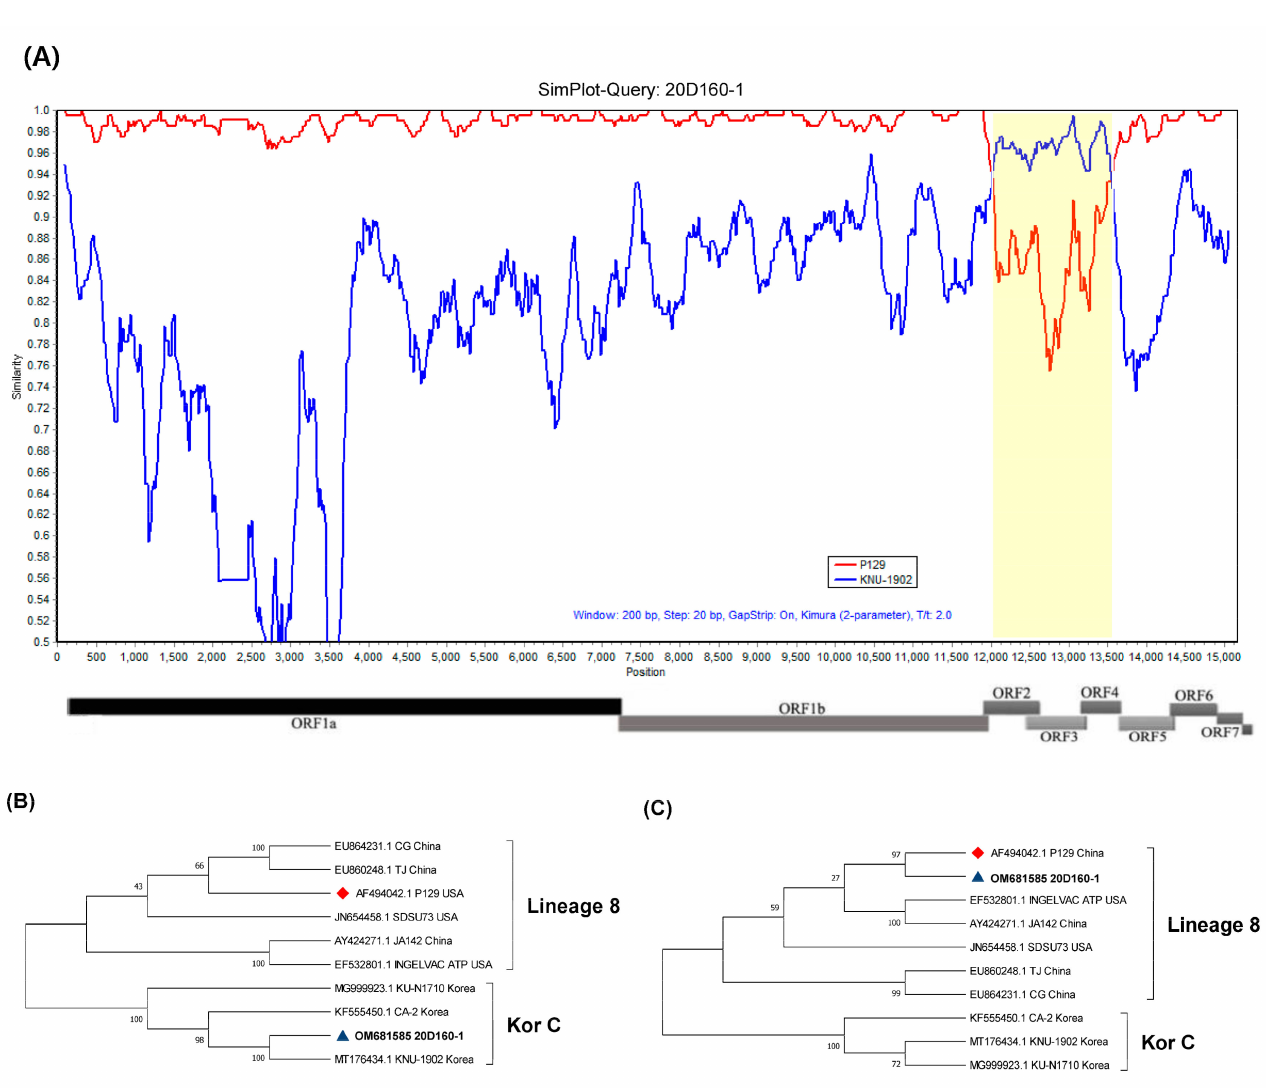
Figure 2. Recombination analyses of 20D160-1 and representative PRRSV lineages. ( A ) Similarity plot and bootscan analyses of 20D160-1 by Simplot. Yellow indicates the recombination region between 11,990 and 13,563, which covers ORF2, ORF3, and ORF4. The y -axis indicates the percentage similarity between the parental sequences and the query sequences. Phylogenetic trees of minor ( B ) and major ( C ) regions. The minor parental region of 20D160-1 was found to be related to KNU-1902-like strains, but the major parental region of 20D160-1 was closely related to the P129 strain. 20D160-1 is indicated ▲ ◆ ), and vaccine strains are indicated by a red diamond ( ▲ ◆ by a blue triangle (